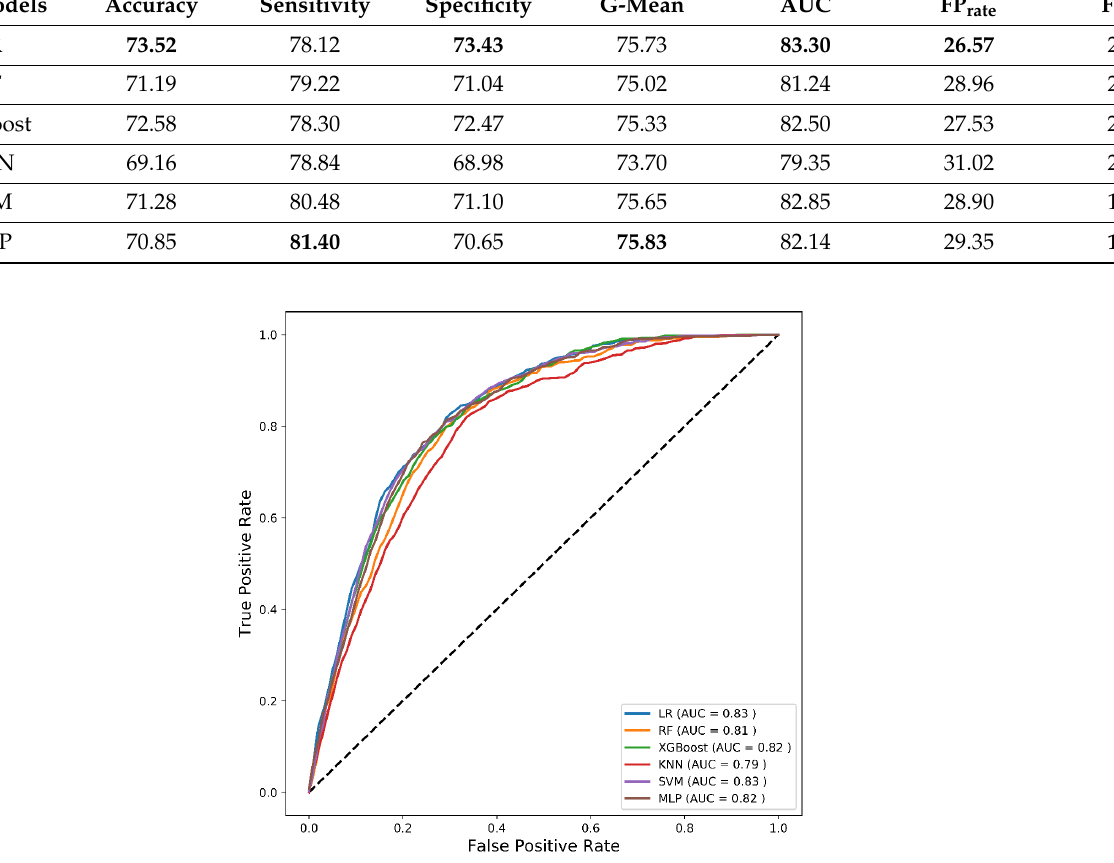
Figure 3. Mean ROC curves of the employed classifiers.